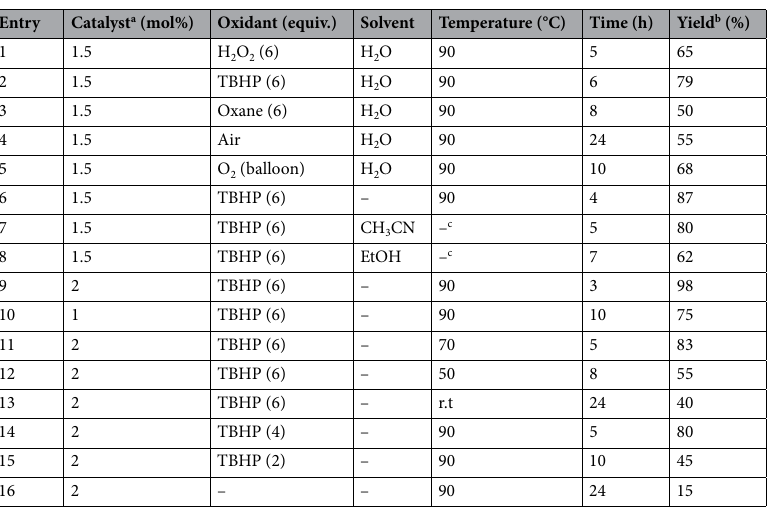
Table 1. Optimization of reaction conditions in the oxidation of benzyl alcohol catalyzed by (γ-Fe 2 O 3 -Im- XPS spectrum of (γ-Fe 2 O 3 -Im-Py) 2 WO 4 and the detailed XPS spectra for each element are presented in Fig. 3. XPS discovered C1s, O1s, N1s, Fe2p, Si2p, W4p, W4d and W4f states in (γ-Fe 2 O 3 -Im-Py) 2 WO 4 (Fig. 3a). In Fig. 3b, high-resolution C1s spectra of the catalyst has three main peaks at 284.5 (C–C and C=C), 286.1 (Csp 2 –N) and 287.9 eV (Csp 3 –N) 72 . The N1s spectrum exhibited two main peaks, revealing the presence of the pyridinic nitrogen (399.2 eV) and C–N (401.4 eV) (Fig. 3c) 73 . The XPS spectra of W4f (Fig. 3d) showed two peaks centered at 34.8 and 36.9 eV, related to W 6+ (W4f 7/2 , W4f 5/2 ) 74 . ICP analysis of (γ-Fe 2 O 3 -Im-Py) 2 WO 4 indicated that 0.35 mmol (0.064 mg) tungstate was immobilized on 1 gr of this compound. The size and morphology of (γ-Fe 2 O 3 -Im-Py) 2 WO 4 were studied using TEM (Fig. 4) and FESEM (Fig. 5). The TEM and FESEM images of (γ-Fe 2 O 3 -Im-Py) 2 WO 4 exhibit the development of uniform sphere-shaped nanoparticles. The average particle size of (γ-Fe 2 O 3 -Im-Py) 2 WO 4 was assessed as 12.4 nm using a size distribution histogram (Fig. 4c). Energy-dispersive X-ray spectroscopy (EDS) was done to approve the presence of each element in this compound. The EDS spectrum (Fig. 5c) displays characteristic signals refer- ring to carbon, nitrogen, oxygen, silicon, iron and tungsten, which shows the immobilizing of WO 4 -Im-Py on the surface of the MNPs. Moreover, elemental mapping was performed to realize the spreading of the elements present in the (γ-Fe 2 O 3 -Im-Py) 2 WO 4 . The elemental mapping images (Fig. 5d–k) reveal uniform distribution of all the elements. The magnetization curves of γ-Fe 2 O 3 and (γ-Fe 2 O 3 -Im-Py) 2 WO 4 were shown in Fig. 6. The magnetizations of γ-Fe 2 O 3 and (γ-Fe 2 O 3 -Im-Py) 2 WO 4 are 68.5 and 64.8 emu/g, respectively. These results indicate the paramagnetic nature of the catalyst. Because of the coating of MNPs, the magnetization value of the catalyst is faintly lesser than that of γ-Fe 2 O 3 . This low decrease in the magnetization does not affect the catalyst isolation from the reaction. Thermal stability of (γ-Fe (Fig. 7) demonstrates the two-step compound decomposition. A 1.1% weight loss can be observed below 219 °C, which is due to removal of physically adsorbed water molecules. In the second stage, 5.1% mass loss can be observed at 219–730 °C due to the decomposition of organic species supported on the MNPs surface. TGA curve also approves the fruitful loading of organic moiety on the surface of MNPs. Figure 8 displays the XRD patterns of the (γ-Fe 2 O 3 -Im-Py) 2 WO 4 . The diffraction peaks positioned at 30.44°, 35.75°, 43.5°, 53.9°, 57.4°, 62.85°, 71.75° and 74.6°, which are indexed to (220), (311), (400), (422), (511), (440), (620) and (533), respectively. Their relative intensities match pretty well with the inverse spinal structure of maghemite according to JCPDS card No. 39-1346 75 . These observations confirmed the existence of γ-Fe 2 O 3 nanocrystals and indicates that the crystalline phase of γ-Fe 2 O 3 did not alter in the stages of the catalyst synthesis.